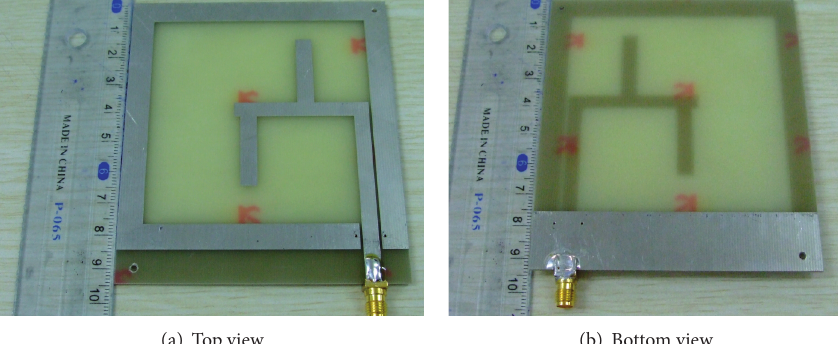
Figure 10: Simulated results of radiation pattern.